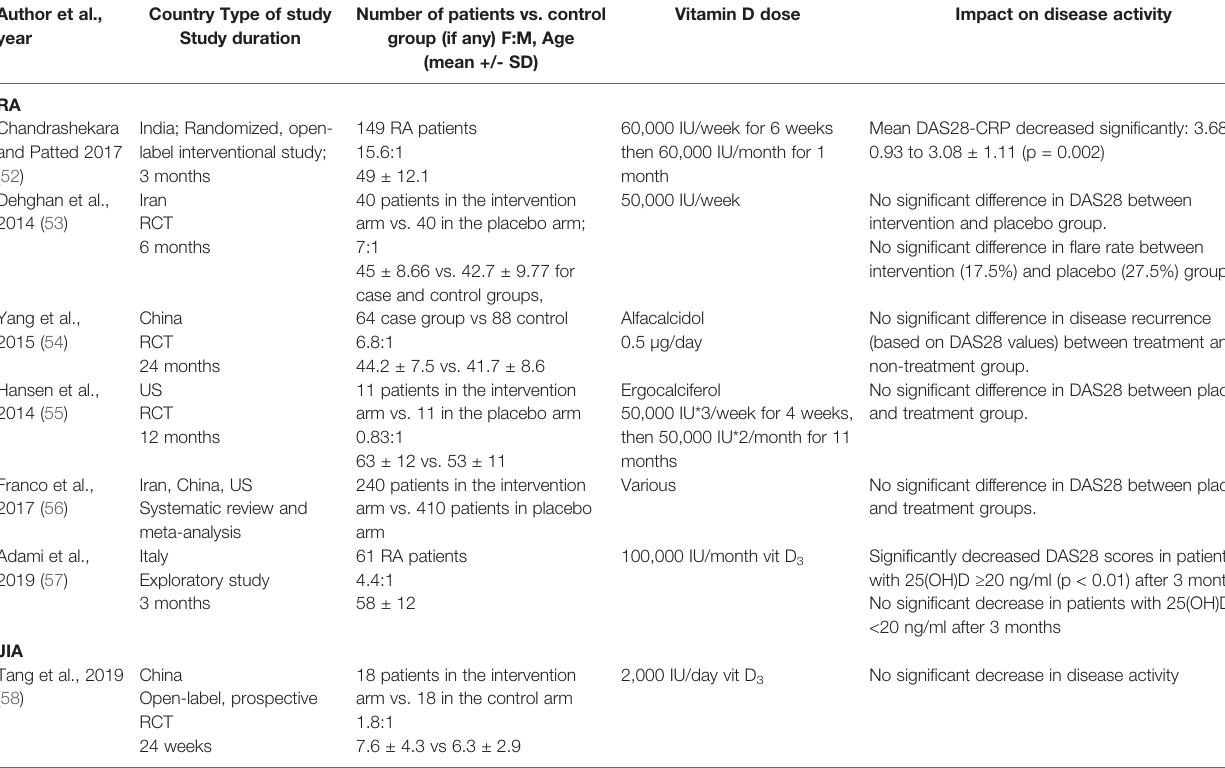
TABLE 3 | Impact of vitamin D supplementation on RA and JIA